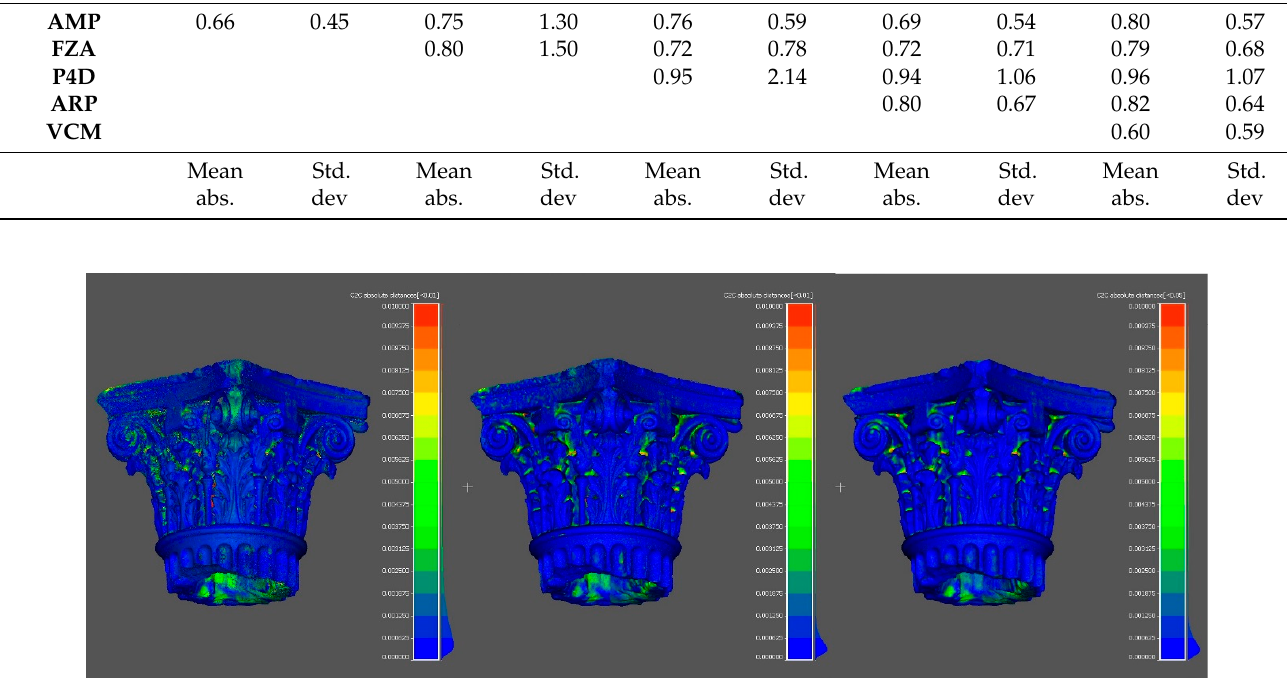
Figure 8. Scalar field mapping of Hausdorff distances for dataset 4 photogrammetric results. Deviation between the ARP mesh and the AMP mesh ( left ), deviation between the ARP mesh and the FZA mesh ( center ), deviation between the ARP and the P4D mesh ( right ); maximum visualized distance: 1 cm.